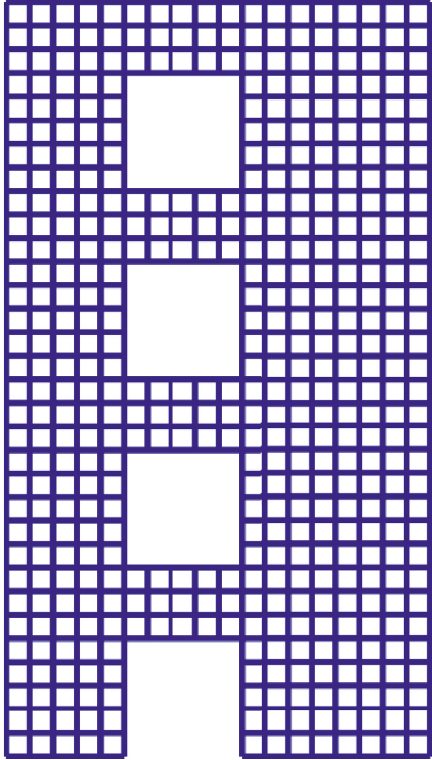
Figure 20: Model of shear wall with four Table 9: Natural frequencies (rad/s) of shear wall.